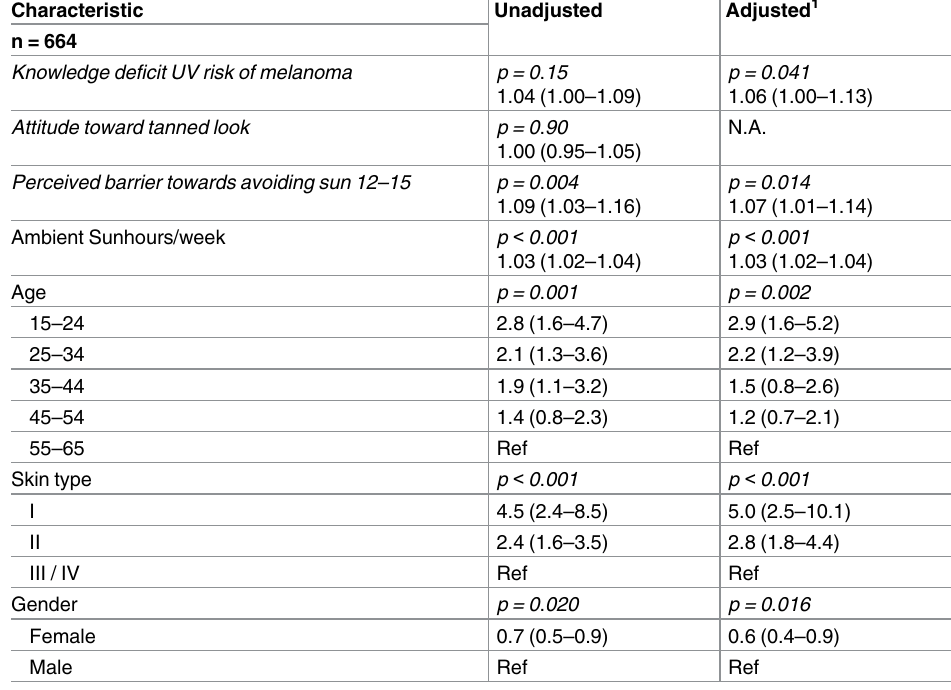
Table 4. Logistic regression models of sunburn and background variables, knowledge deficit, atti- tude and behavior scales.